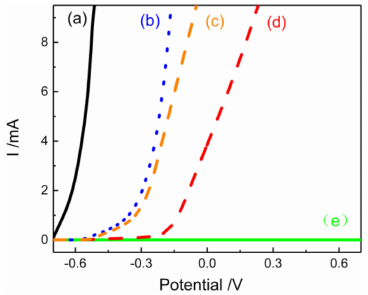
Figure 10. The electrochemical curve of steel substrate (a), epoxy coatings (b), epoxy coatings containing 30-min PAN fibers (c), self-healing composite coatings with di ff erent fiber deposition time on the steel substrate: 15-min core-shell fibers (d) and 30-min core-shell fibers (e). When the fiber deposition time was more than half an hour, the current tended to 0 mA and curves coincided, which indicated that self-healing coating are e ff